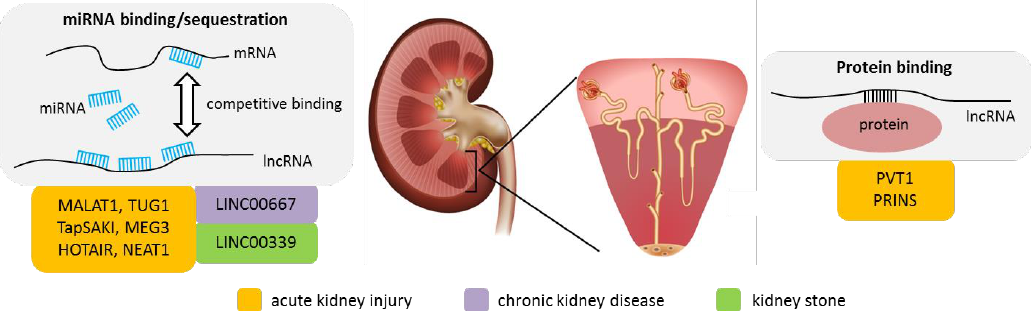
Figure 2. LncRNAs in tubulointerstitial disease and their reported molecular functions. Grey colored boxes depict the molecular mechanisms of lncRNA function (miRNA binding/sequestration and protein binding) reported to play a role in tubulointerstital disease. Orange, purple and green colored boxes indicate the disease: acute kidney injury, chronic kidney disease and kidney stone, respectively. The lncRNAs associated with the particular mechanism and disease are specified by name. Kidney image obtained from: Tefi/shutterstock.com.